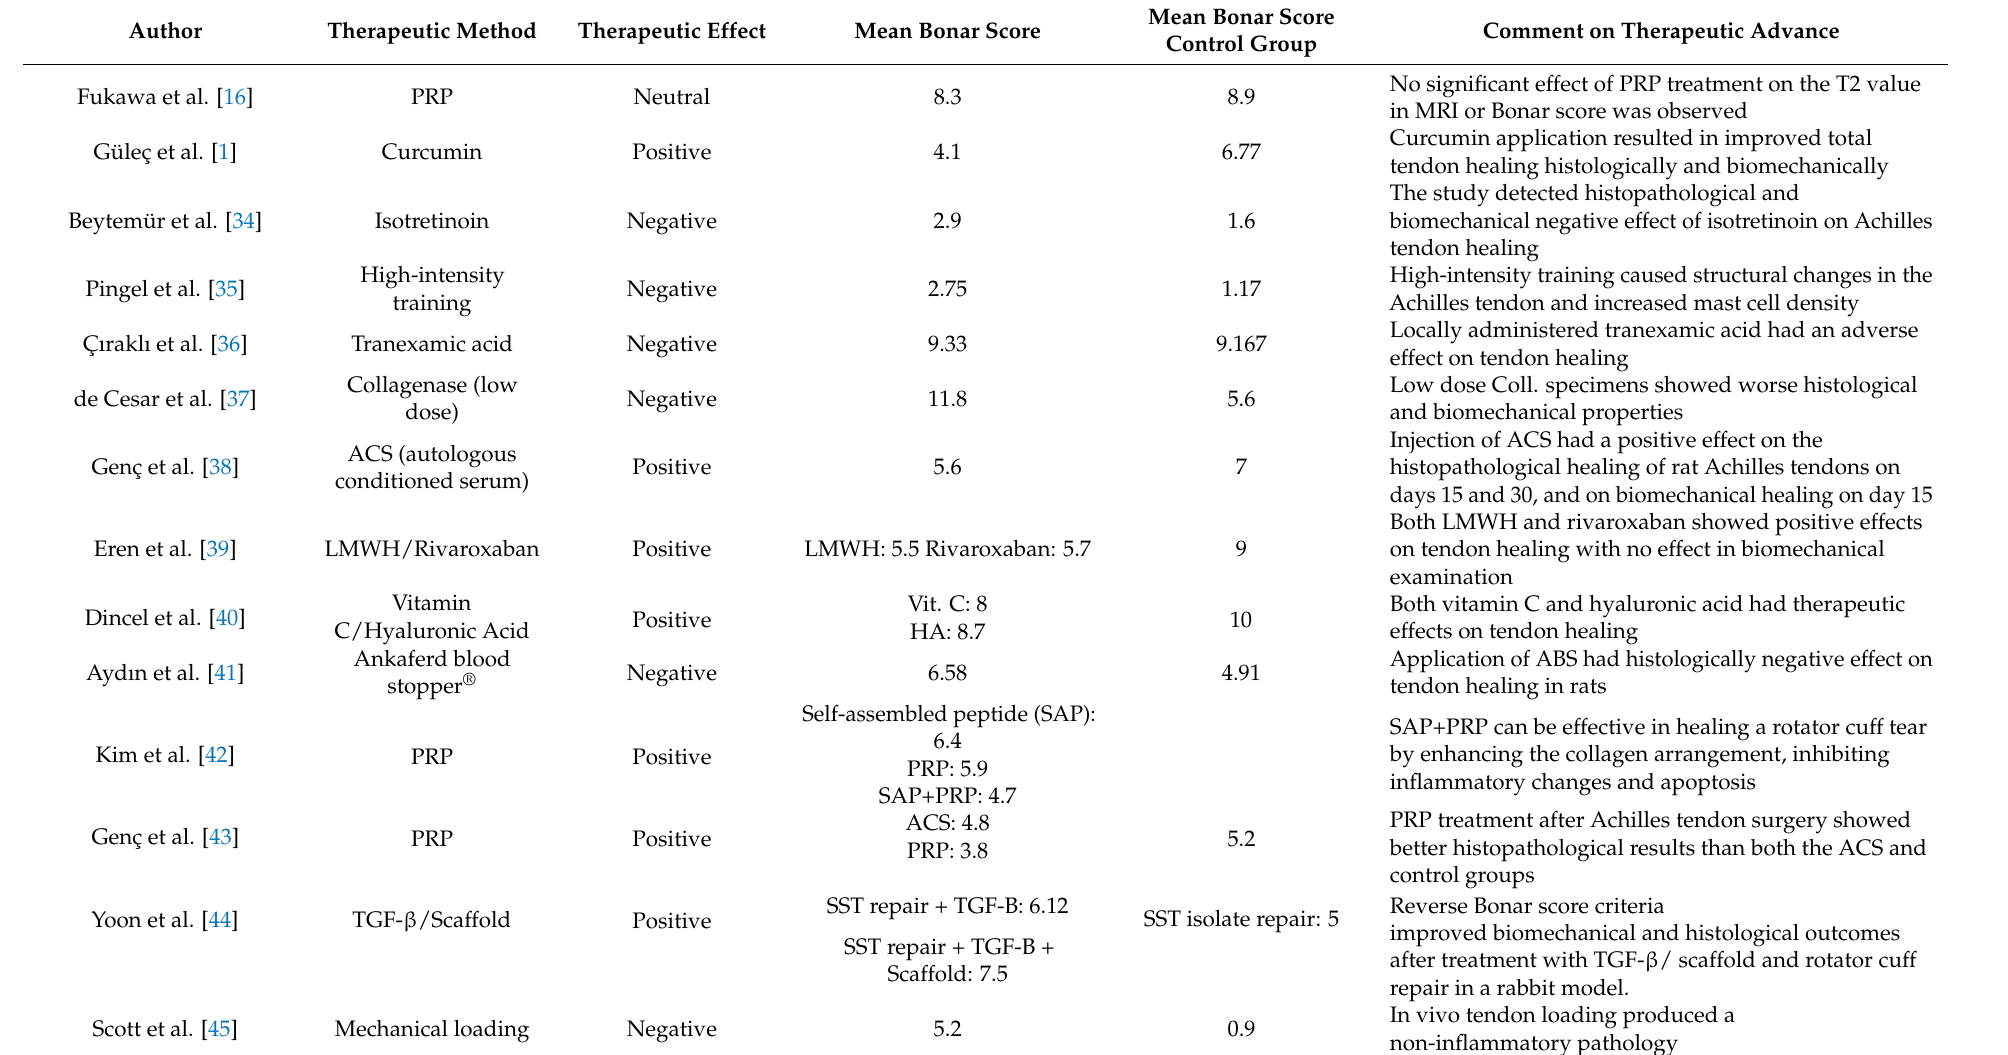
Table 3. Therapeutic methods, clinical effects, and their influence on the Bonar